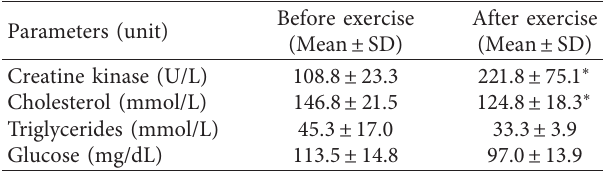
IE1 and IE2 are Beagles that performed interval exercise. Table 7: Changes in biochemistry parameters in four Beagles subjected to continuous or interval